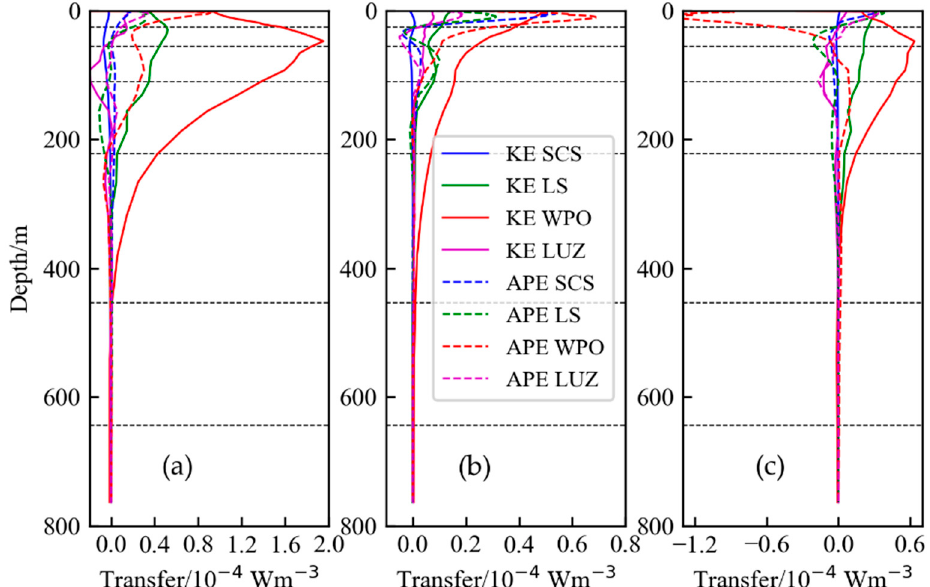
Figure 11. Profiles of temporally and horizontally averaged canonical transfers in four subregions (see Figure 1 for locations). The black dotted lines (from top to bottom) in each subgraph indicate depths of 25, 56, 110, 222, 454 and 644 m, respectively. ( a ) Γ K 0 2 and Γ A 0 2 ; ( b ) Γ K 1 2 and Γ A 1 2 ; ( c ) Γ K 0 1 and Γ A 0 1 .